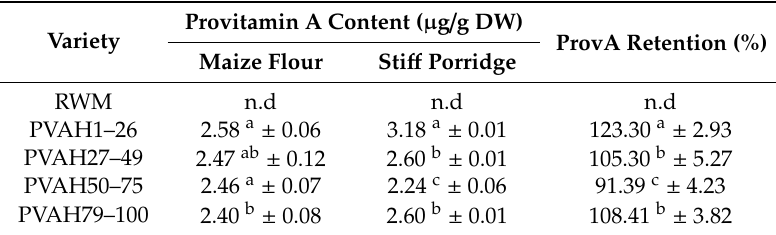
Table 3. Provitamin A retention in provitamin A-biofortified maize sti ff porridges and the representative white maize